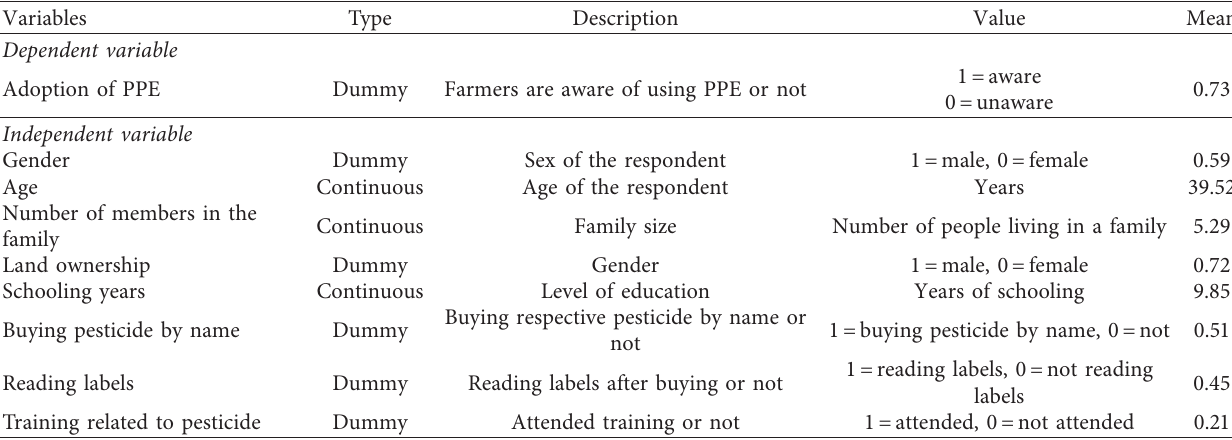
Table 2: Description of variables used in the binary logit model.